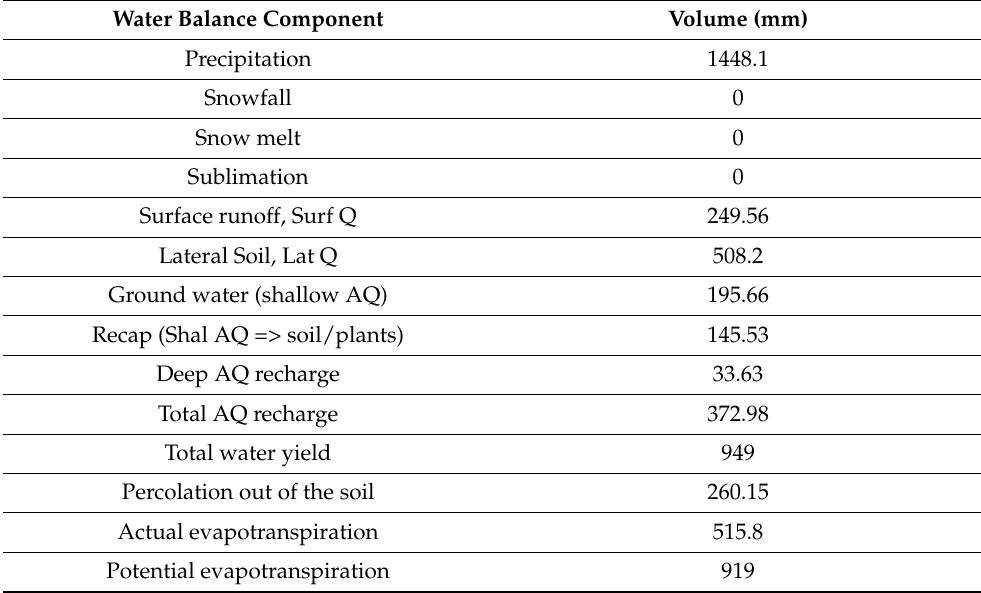
Table 4. Average annual basin values of water balance components in the Babai River Basin during the calibration and validation periods (2003 to